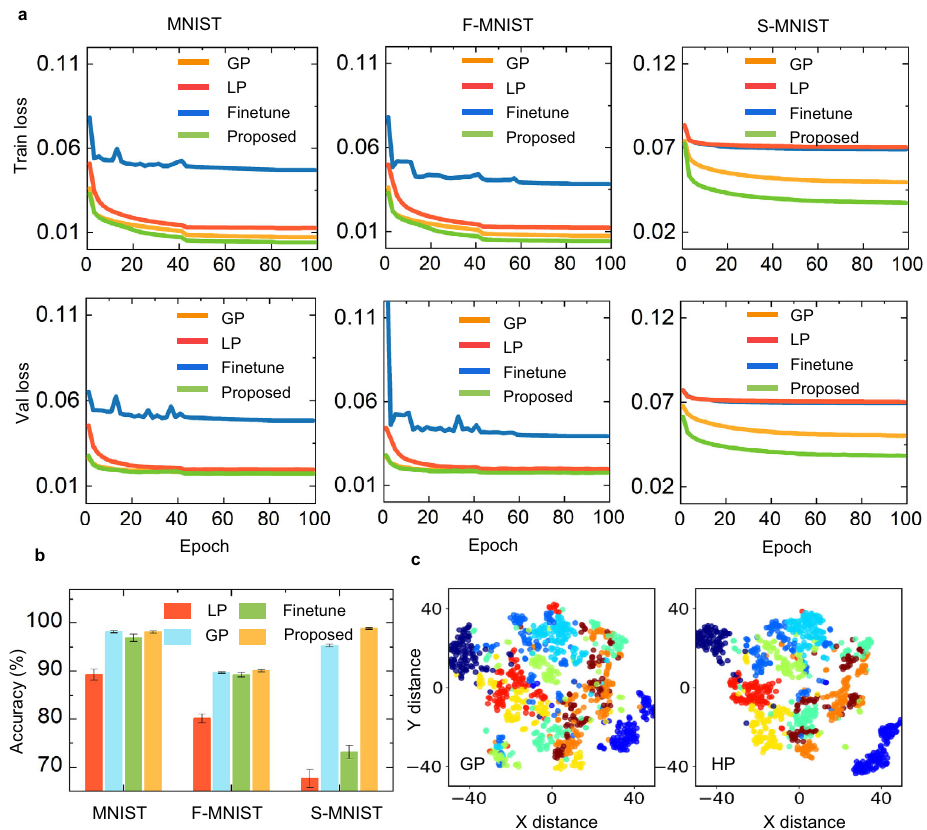
Fig. 3 The hybrid plasticity approach can effectively ensure the convergence and accuracy of the proposed hybrid synergic learning. a Comparison of the convergence curves of the single GP-based, LP-based, fi ne-tuning-based (denoted by Finetune) and the proposed HP model over MNIST, Fashion- MNIST (F-MNIST), and Sequential MNIST (S-MNIST). b Accuracy histogram for the four models. The error bar indicates the standard derivation for ten repeated trials. * P < 0.05. Two-sided t -test was applied to assess statistical signi fi cance. c T-distributed stochastic neighbor embedding visualization of the average fi ring rate in the fi rst hidden layer using